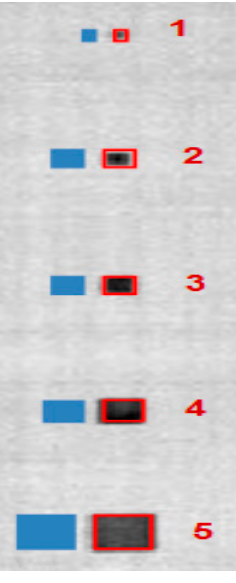
Figure 2. Selection of the sound area for each detected defect in order to calculate the peak slope time from the respective thermal contrast curve in the time domain analysis.